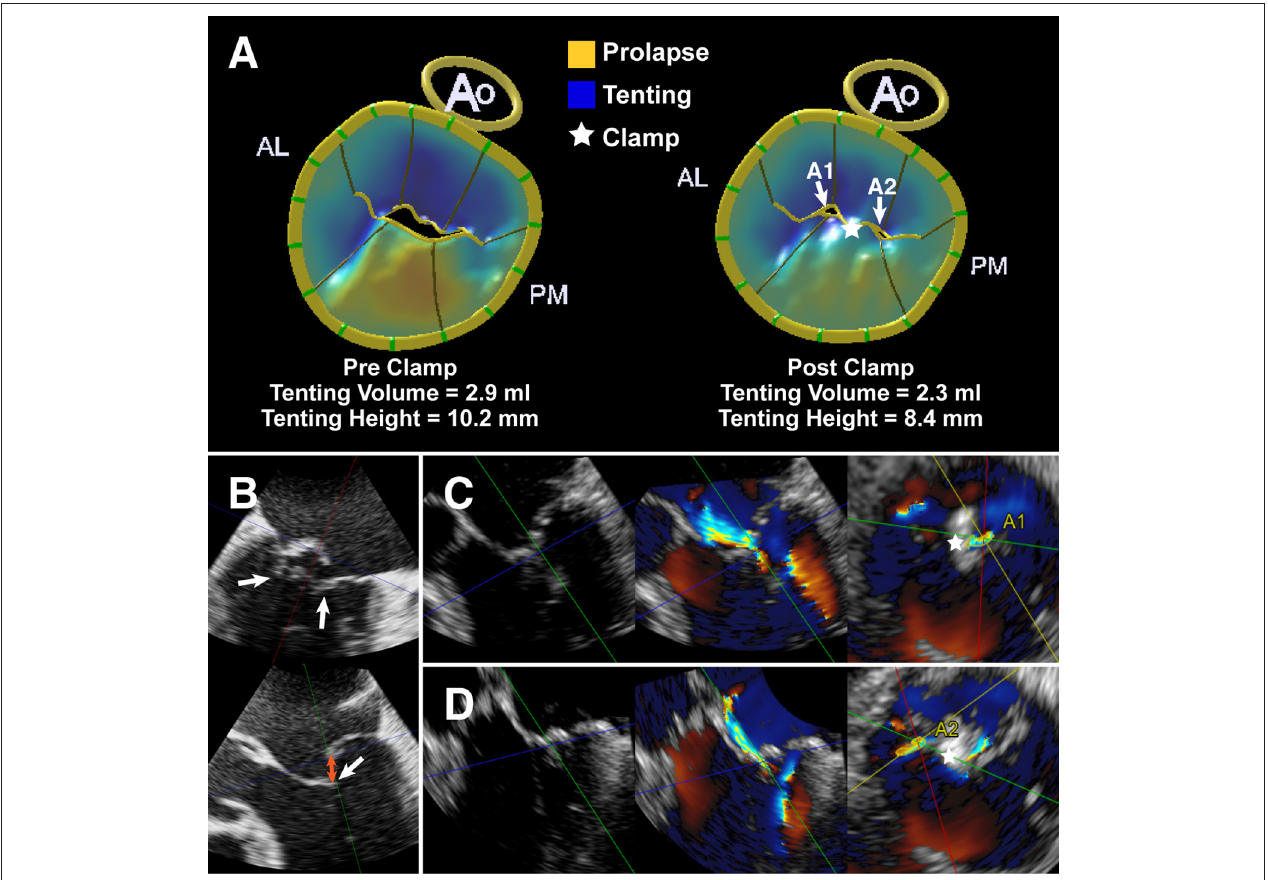
FIGURE 4 | A typical case with P2 prolapse/flail and secondary bileaflet tethering. (A) Left: MV modeling from MVN analysis vividly demonstrating a prolapsing P2 scallop (shaded yellow) and tented scallops (shaded blue). Right: MV modeling showing the residual tenting volume (shaded blue) and residual regurgitant orifice (A1 and A2). (B) MV commissural view and long-axis view derived by multiplanar reconstruction (MPR) from real-time 3D dataset showing preoperative P2 prolapse/flail and leaflet tethering (white arrow). Orange arrow indicates the flail/coaptation gap. (C,D) MPR images derived from 3D Color Doppler dataset showing leaflet